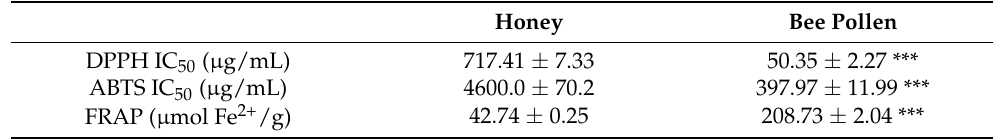
Values are expressed as mean ± SD. *** p < 0.001 vs. Honey